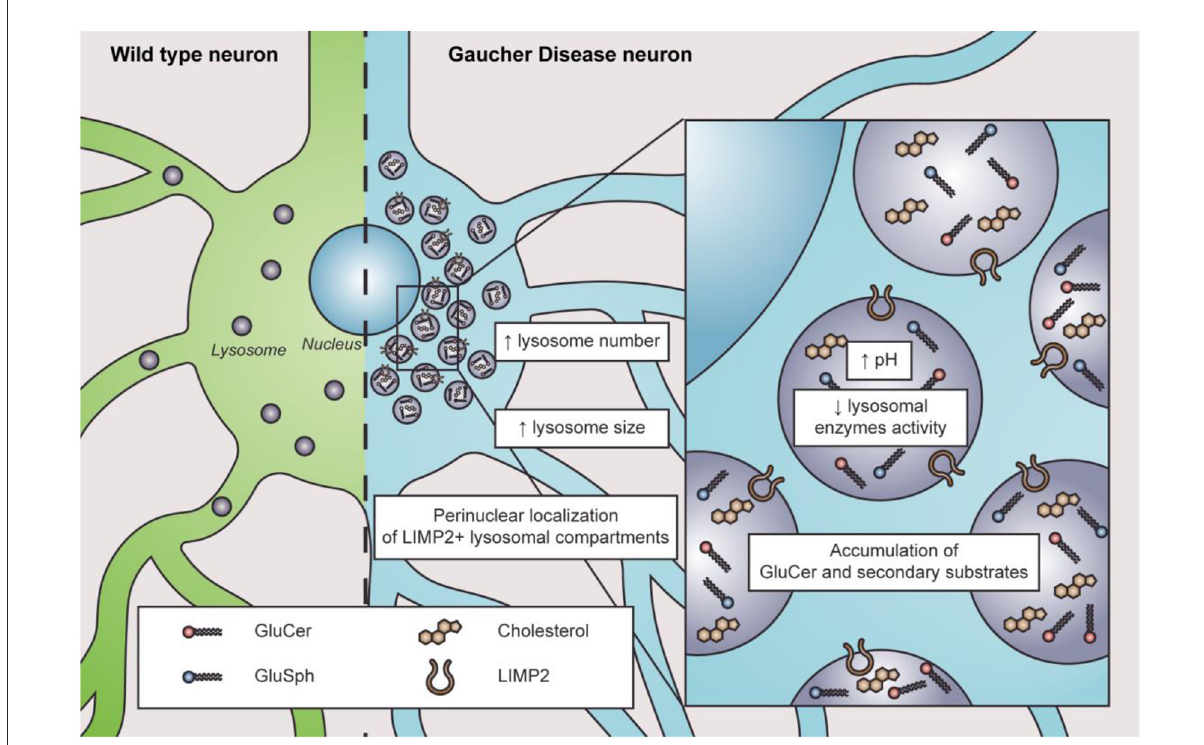
FIGURE1 Characteristics of lysosome dysfunction in nGD. In physiological conditions, lysosomes are distributed throughout the cytosol in wild-type neurons (left in green). In nGD, lysosomes are increased in number and size with a perinuclear localization of LIMP2 + lysosomal compartments accompanied by elevated intraluminal pH and decreased lysosomal enzyme activity, along with the accumulation of GluCer and secondary substrates such as glucosylsphingosine (GluSph) and cholesterol (right in light